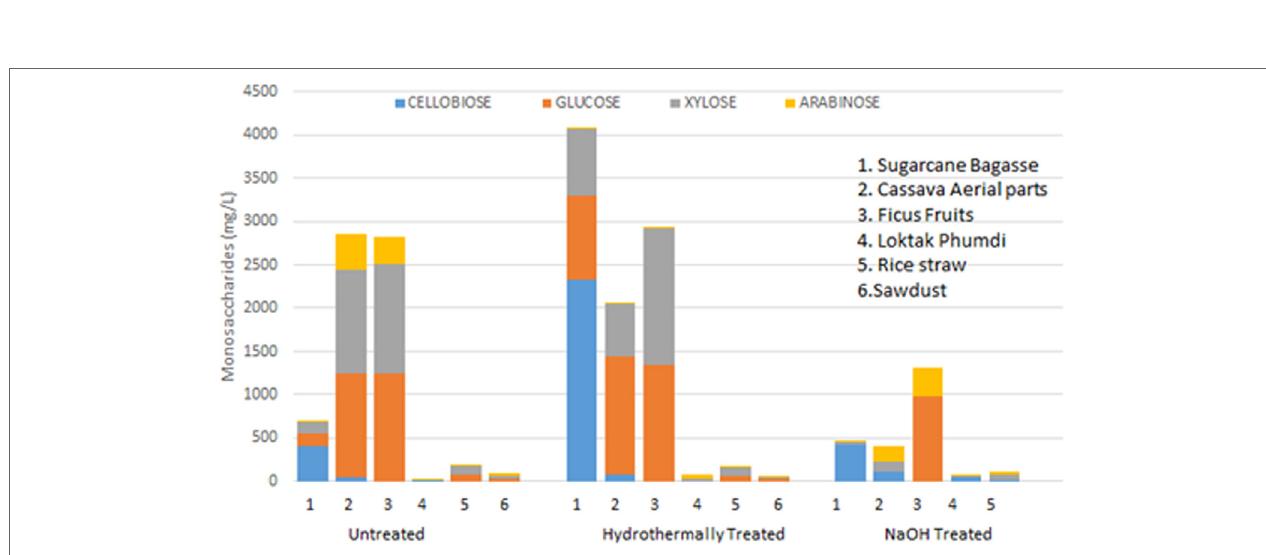
FigUre 3 | (a) Loading plots of PC1 and PC2 of Fourier transform infrared (FTIR) spectra for the different biomasses. (B) Scores scatter plot of principal components PC1 and PC2 for the FTIR spectra of different biomasses under study. The acronyms provided are abbreviated for sugarcane bagasse (BG), cassava aerial parts (CS), ficus fruits (FF), rice straw (RS), and sawdust (SD). The suffix denotes U, untreated; T, hydrothermally treated; and N, sodium hydroxide treated corresponding to the symbols representing ( ▴ ), untreated; ( ♦ ), hydrothermally treated; and ( ▪ ), sodium hydroxide treated,